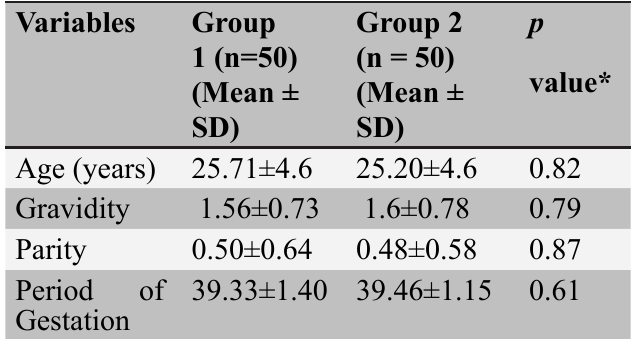
Table 1. Comparison of demographic